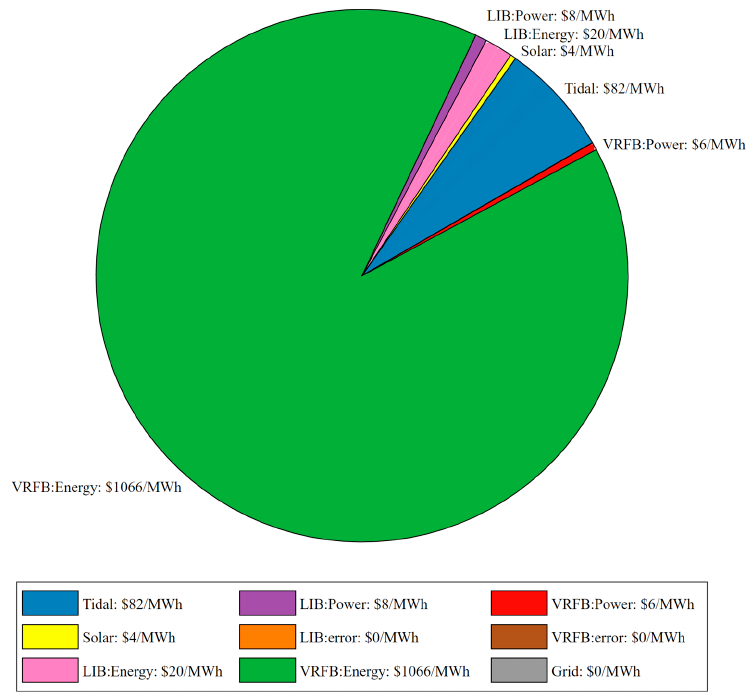
Figure 4. A pie chart demonstrating the breakdown of each microgrid component’s contribution to the total system LCOE. The energy storage cost of the VRFB is the primary contributor to the LCOE. Note: Grid, VRFB error, and LIB error energy storage costs are all USD 0/MWh.